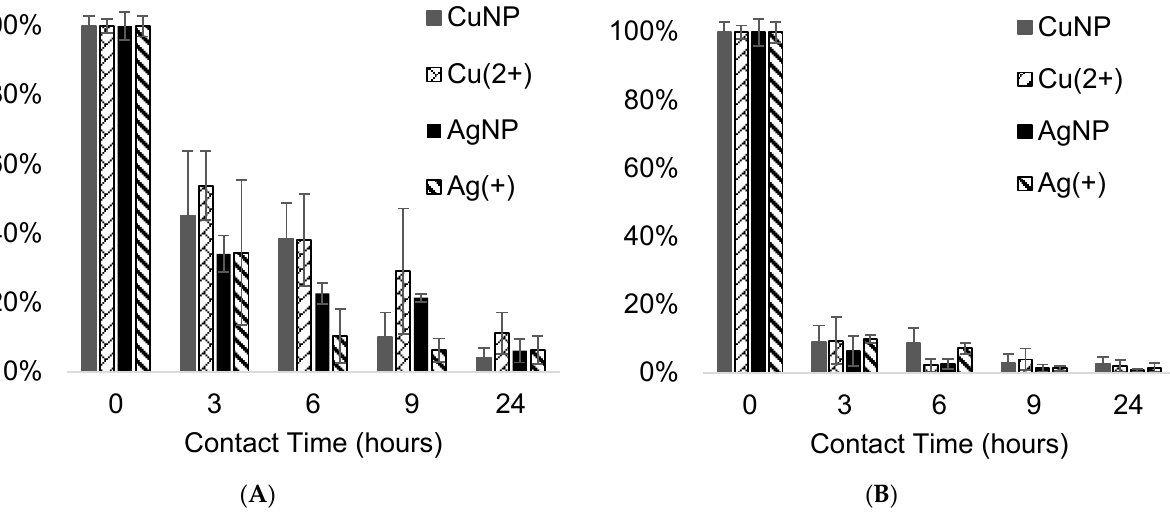
Figure 9. Time-course of E. coli viability in the presence of 0.1 mg/mL ( A ) and 1 mg/mL ( B ) of CMC samples.